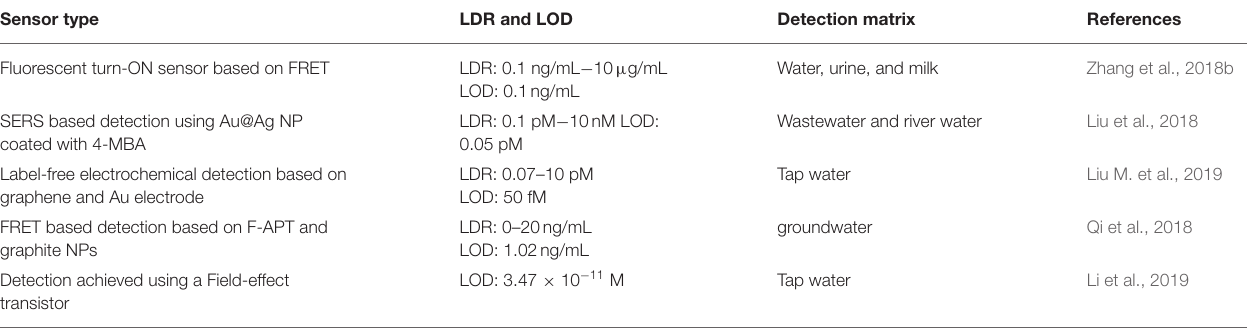
TABLE 2 | Aptamer-based biosensors for the detection of 17 β -estradiol in environmental water sources. Sensor type